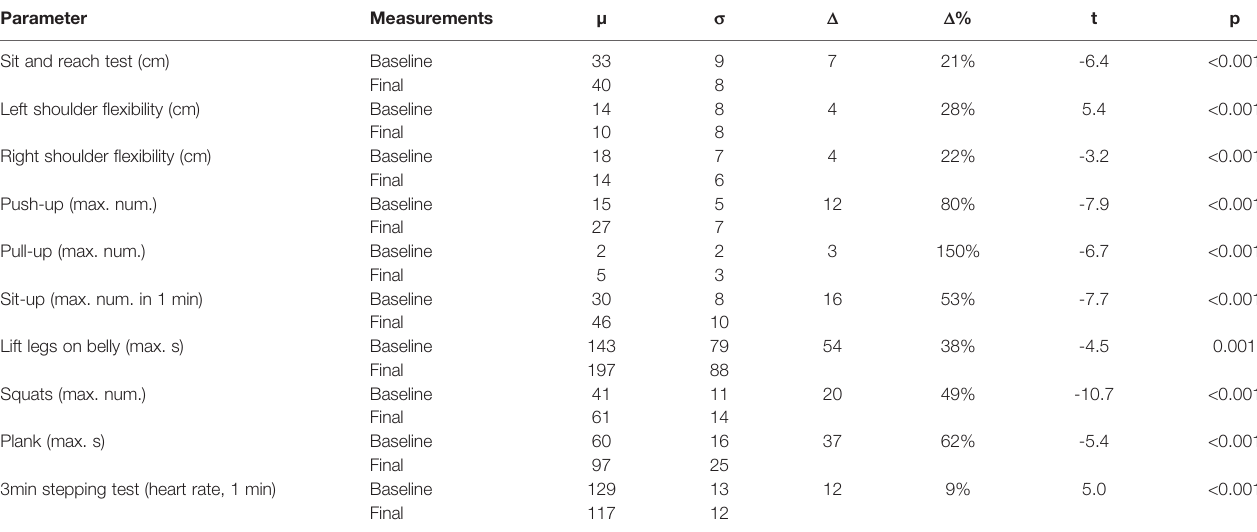
TABLE 7 | Motor capability skills comparison during baseline and fi nal visit measurements. Parameter